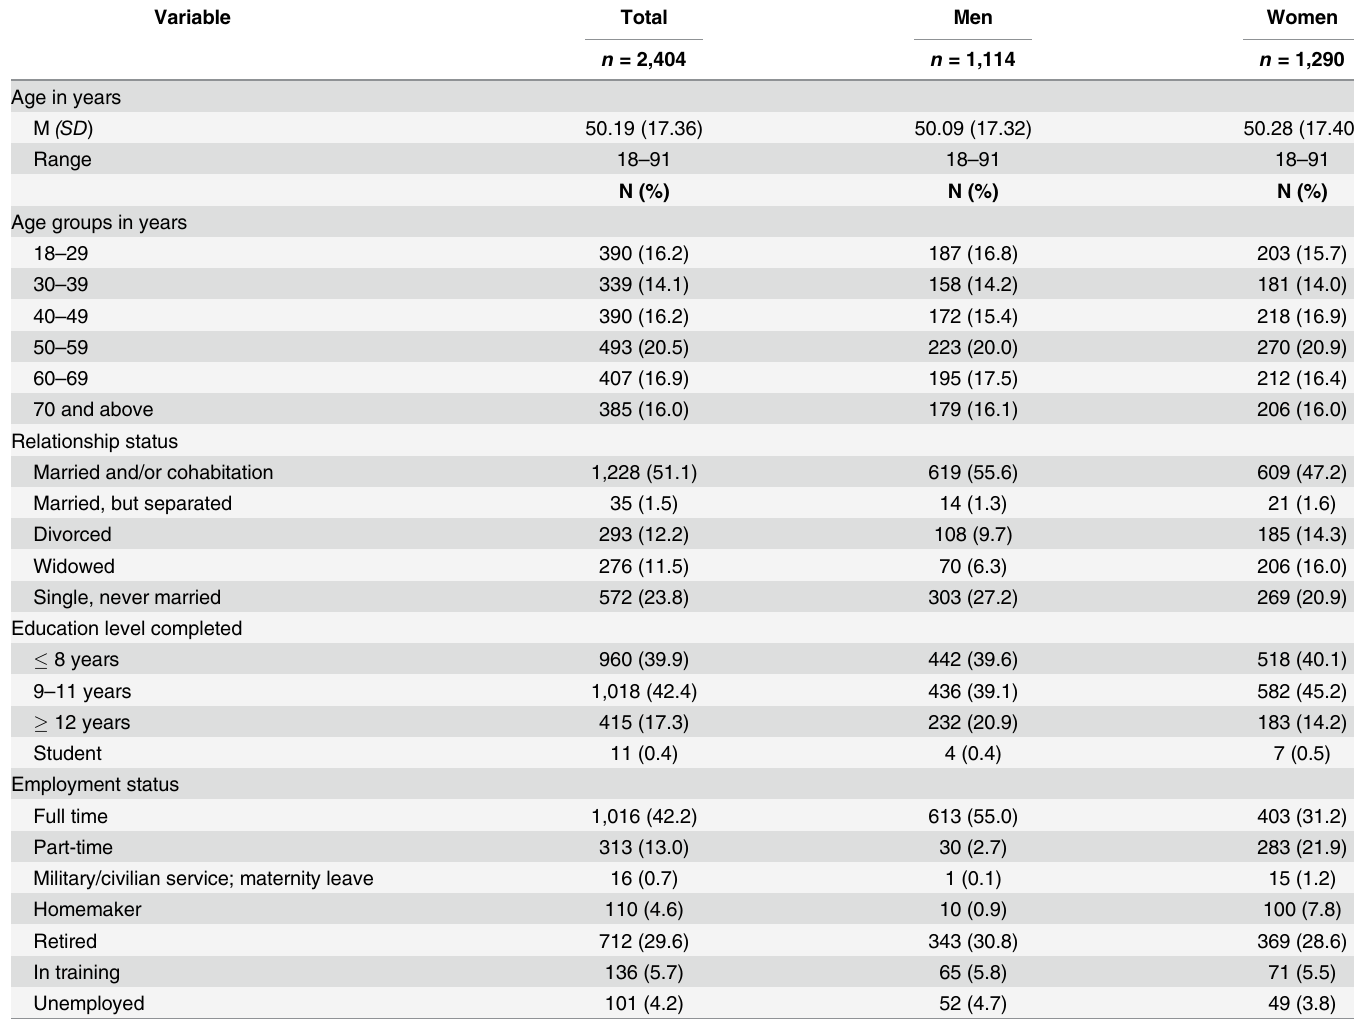
Table 1. Socio-demographic Characteristics of the Study Sample (n =